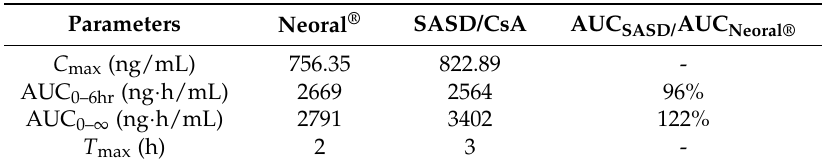
Figure 6. Cyclosporine A (CsA) concentrations in the plasma of rats treated orally with Neoral ® and spherical amorphous solid dispersion based on Poly- αβ -CD copolymers (SASD/CsA). Rats received CsA (10 mg/kg) and for each product. Three rats were used. Table 2. Pharmacokinetic parameters of cyclosporine A (CsA) after the oral administration of Neoral® (cyclosporine A in a microemulsion) or spherical amorphous solid dispersion based on Poly-αβ-CD copolymer containing CsA (SASD/CsA).